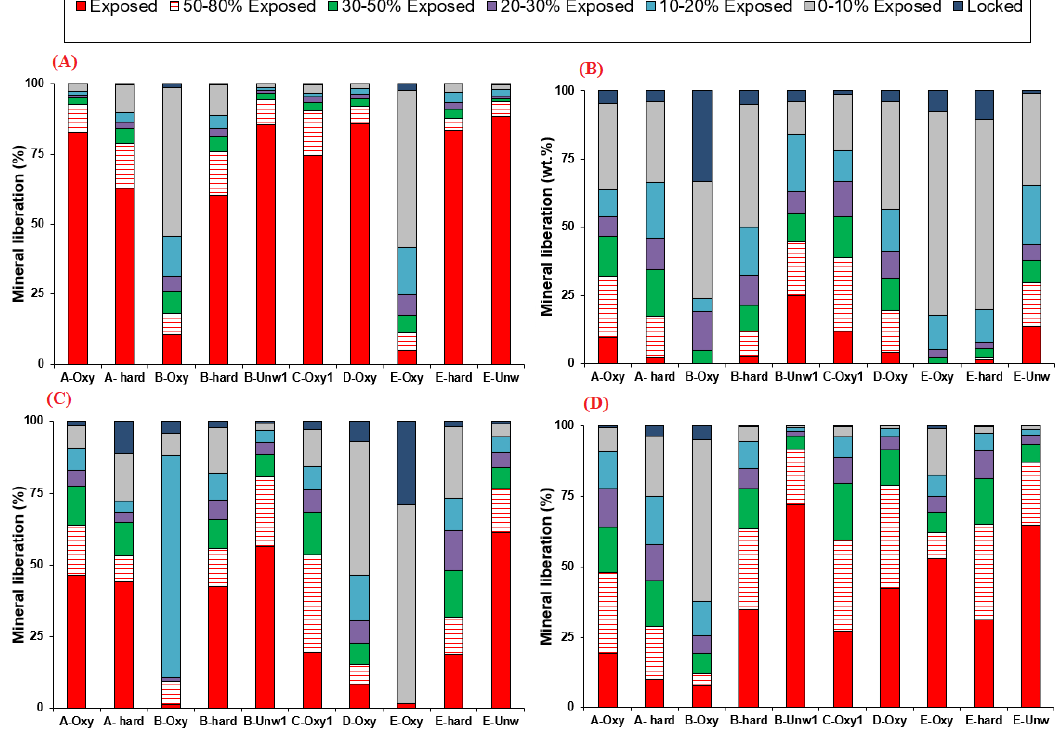
Figure 6. Mineral liberation of pyrite ( A ), pyrrhotite ( B ), calcite-dolomite ( C ), and ankerite-siderite ( D )